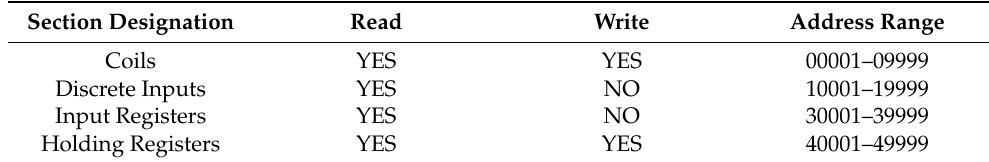
Table 3. Modbus addressing